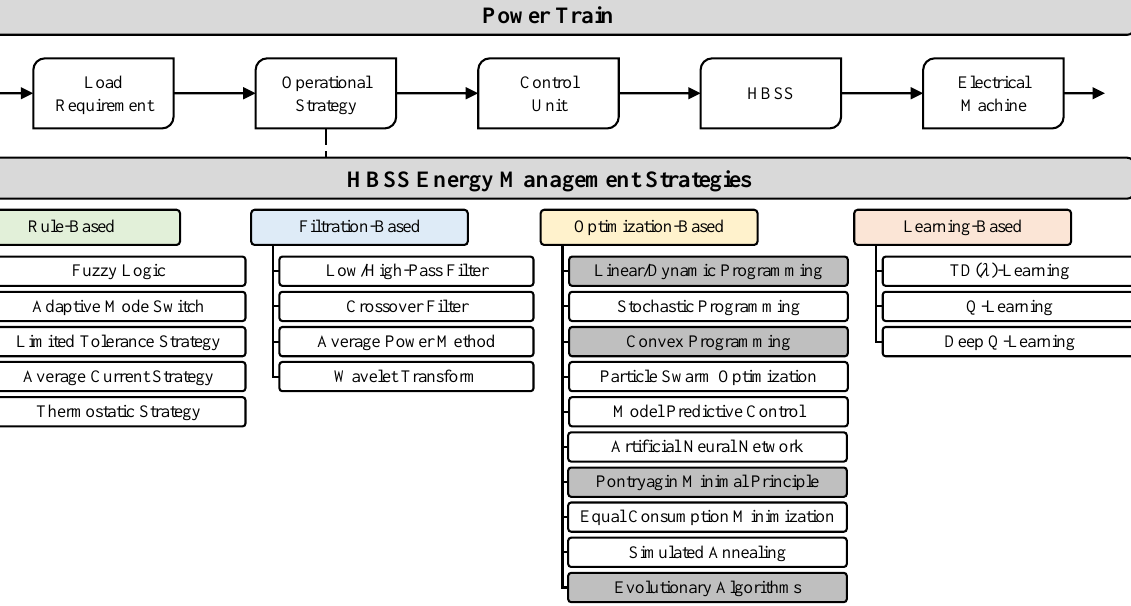
Figure 9. Categorization of different energy management strategies for an HBSS based on [499]. Online strategies are marked with a white background, offline strategies with a gray